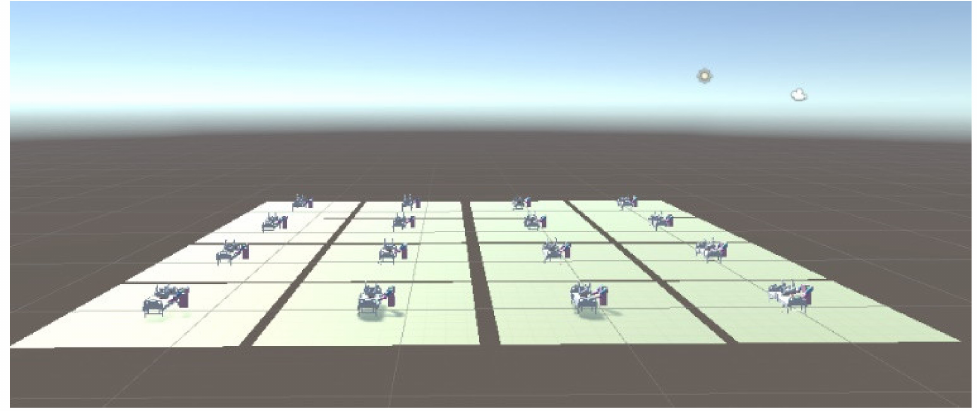
Figure 11. Training environment.